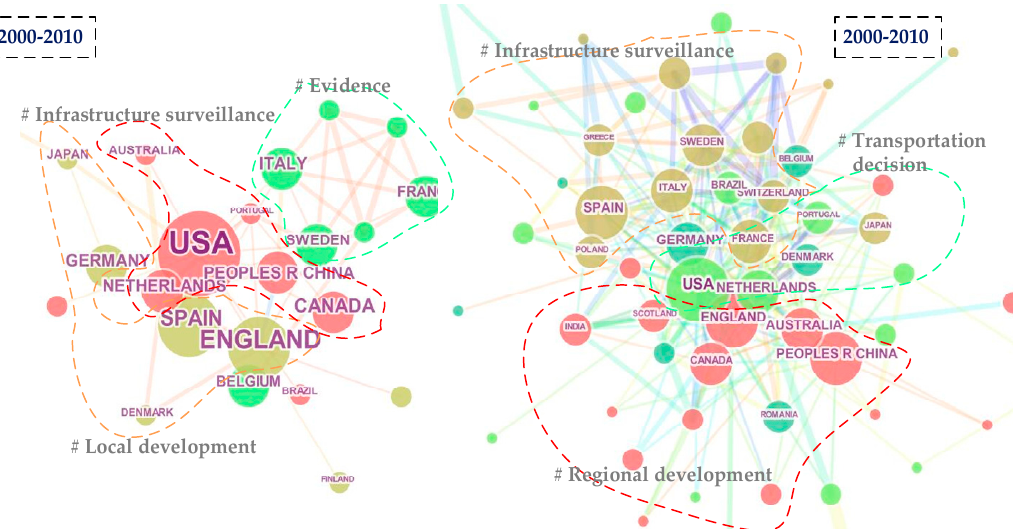
Figure 6. Comparison of country collaboration network.